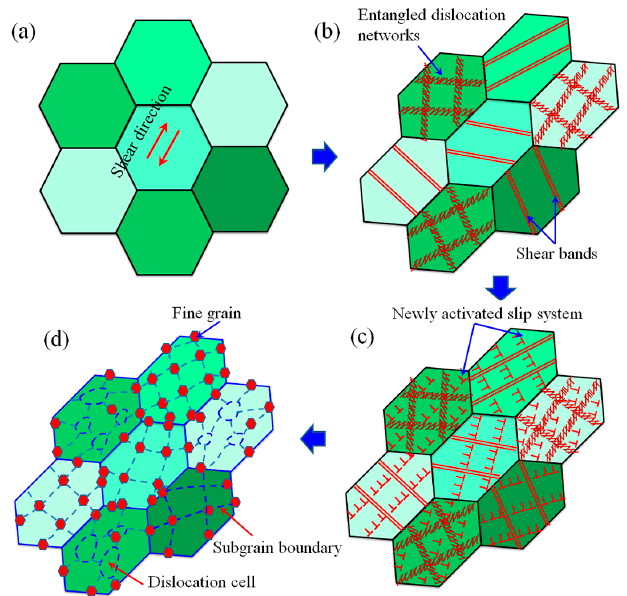
Figure 8. The proposed mechanism for the grain refinement of NiTiFe SMA subjected to single-pass ECAE: ( a ) Equiaxed coarse grains before ECAE; ( b ) microstructure at the early stage of ECAE, showing original coarse grains being elongated along the shear plane and the formation of shear bands and entangled dislocation networks; ( c ) the activation of other slip systems and the block of later induced dislocations; ( d ) rearrangement of dislocations, formation of dislocation cells, subgrains and newly fine grains induced by continuous recovery (In the figure, different background colors represent different orientations).